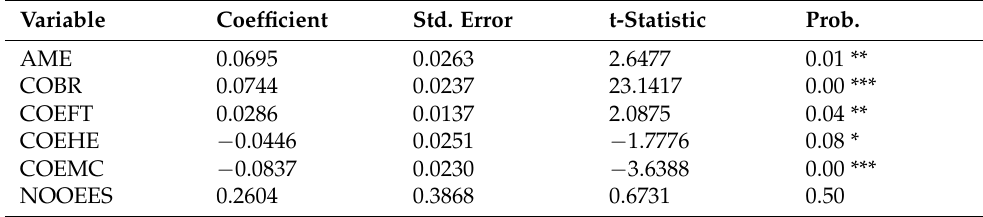
Table 6. Long-run